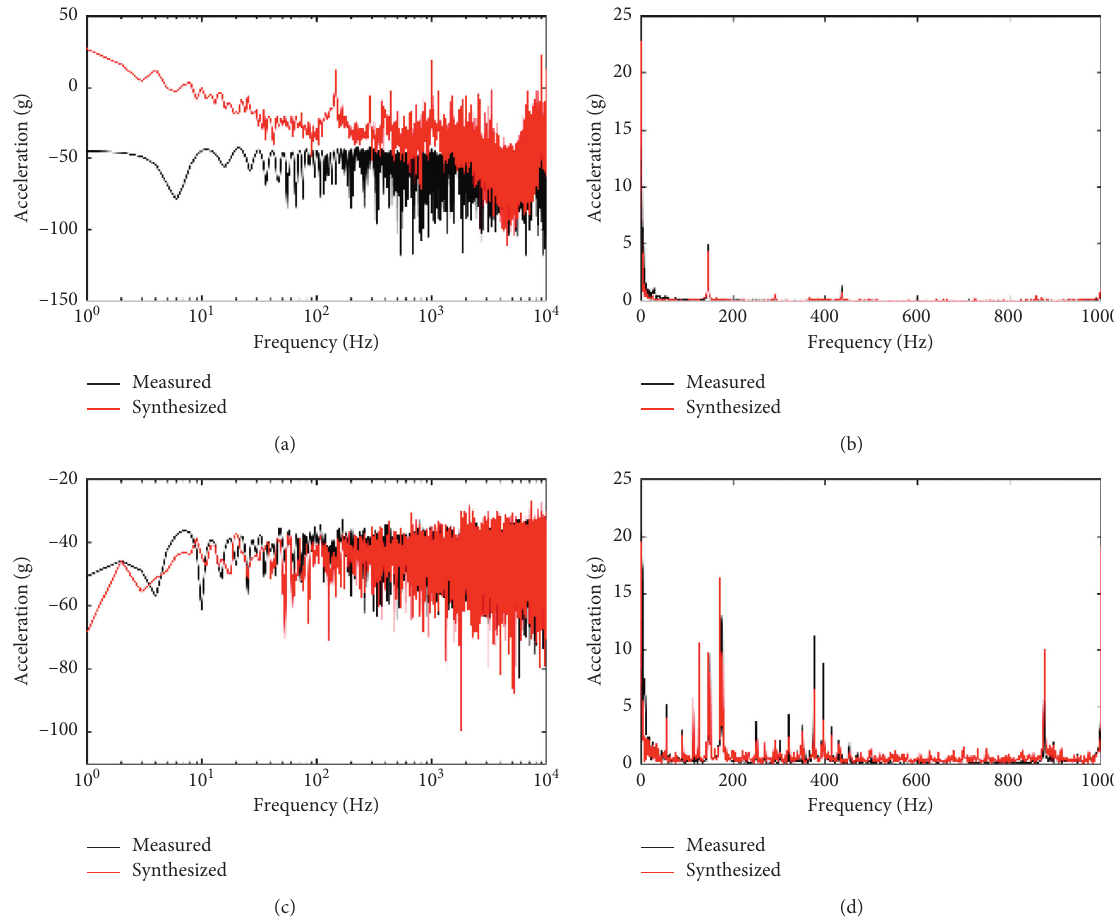
Figure 21: Vibration response (left) and frequency spectrum (right) at different motor correlations: (a) correlation � 80%; (b) correlation � 80%; (c) correlation � 20%; (d) correlation � 20%.